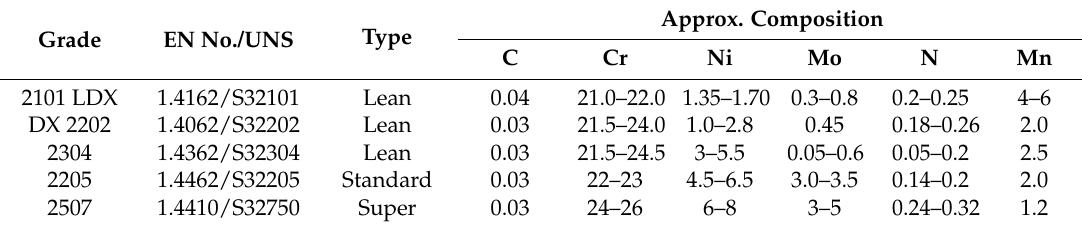
Table 1. Typical compositions (in % atom fractions) of some commonly used duplex stainless steels [38]. LDX (Lean Duplex): DX (Duplex): EN (European standard): No. (Number): UNS (Unified Numbering System for Metals and Alloys).